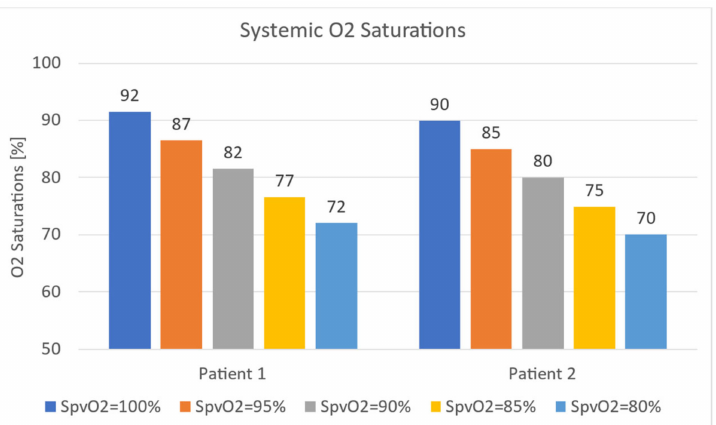
Figure 33. In-vitro analysis of systemic oxygen saturation for patient 1 and patient